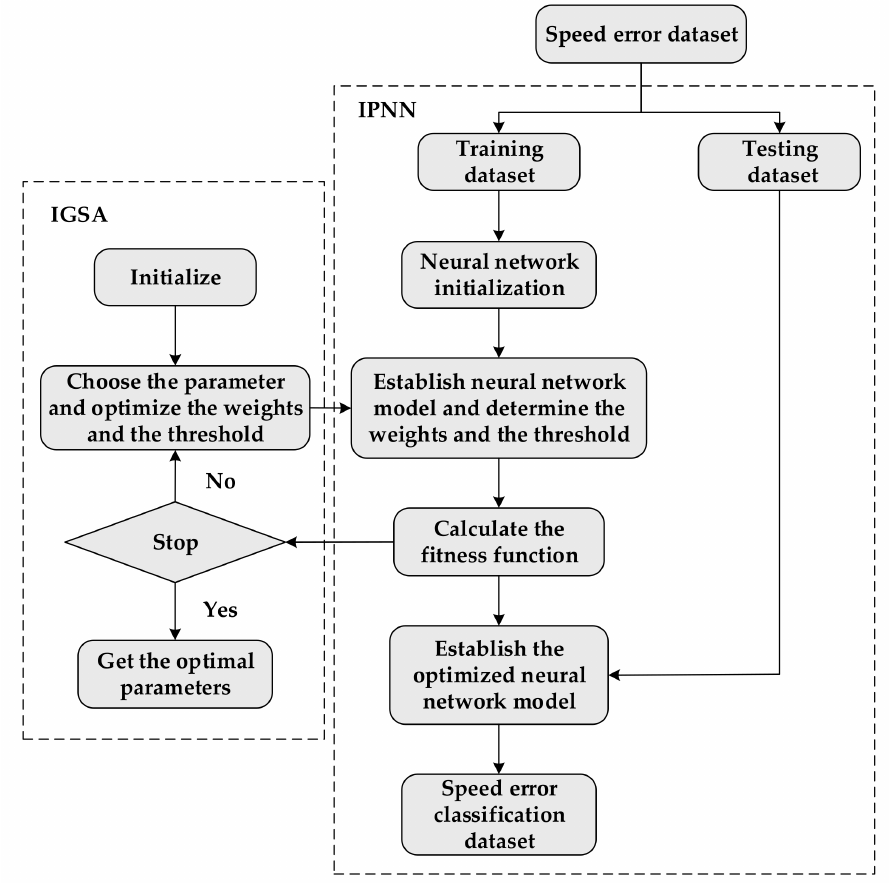
Figure 6. The flow chart of the